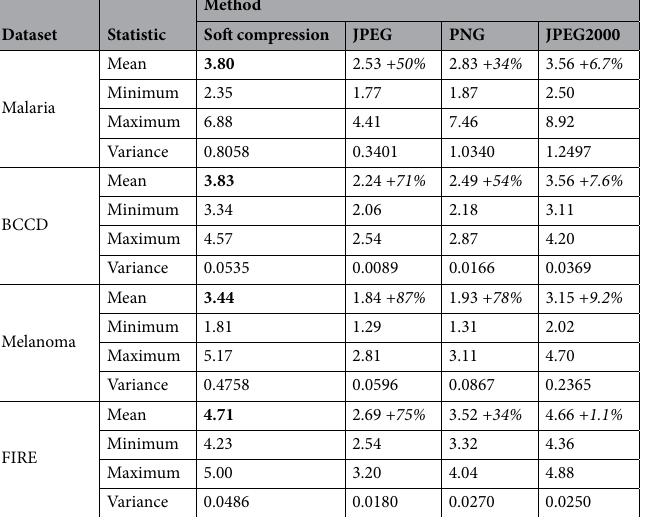
Table 1. Some statistics about compression ratio of image datasets with different compression methods (all methods are lossless compression). Significant values are in bold and italics.